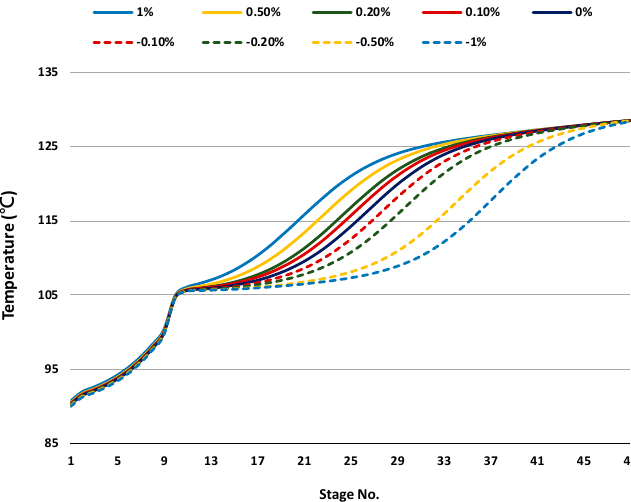
Figure 3. Sensitivity of stage temperature on percent variation of reboiler duty.